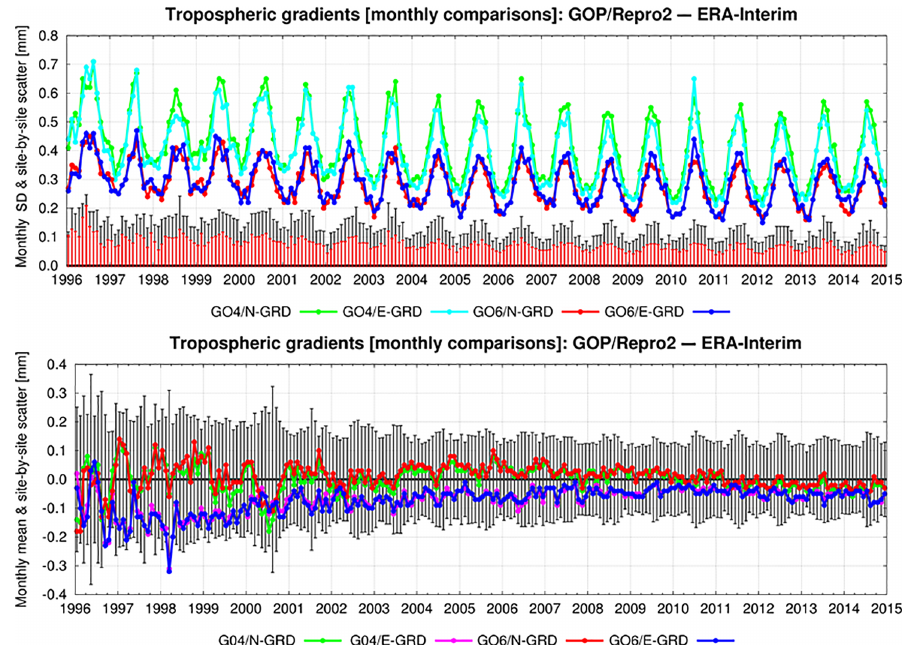
Figure 9. Monthly means of bias and standard deviation of tropospheric horizontal north (N-GRD) and east (E-GRD) gradients compared to those obtained by the ERA-Interim. Note that similar products are almost superposed. Error bars indicate standard errors of mean values over all compared stations plotted from the zero y axis to emphasize seasonal variations and trends. Error bars are displayed for north gradients only; however, they are representative for the east gradients